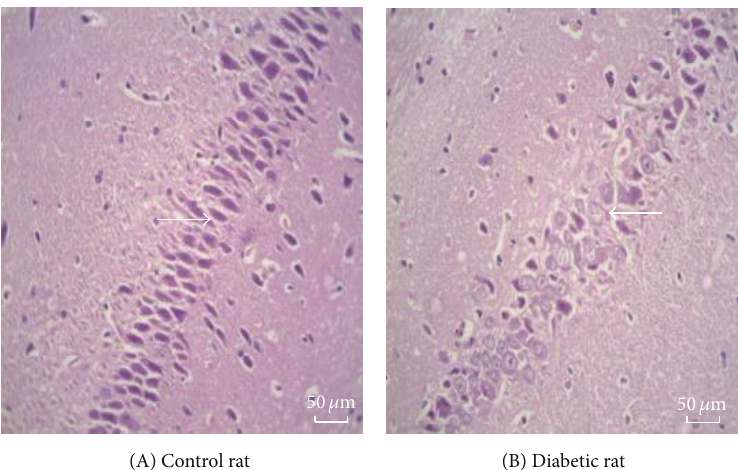
Figure 1: The representative photos of hippocampal tissue in rats. (A) Control rat; (B) diabetic rat. The neurons in rat hippocampal tissue (mainly pyramidal cells) in control rat group are round or oval in shape, with large and lightly stained cytoplasm also round in shape and orderly arranged nucleus. In diabetes rat group the morphology of the neurons was obviously abnormal in hippocampal tissue. The number of neurons decreased, cells were swelling, and nuclear fragmentation or disappearance was observed, as in cell